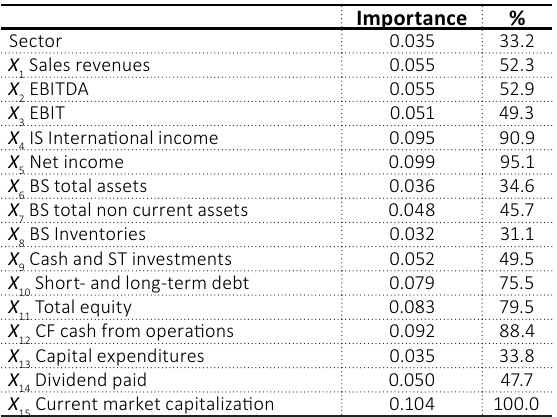
Table 8. Relative importance of the exogenous variables